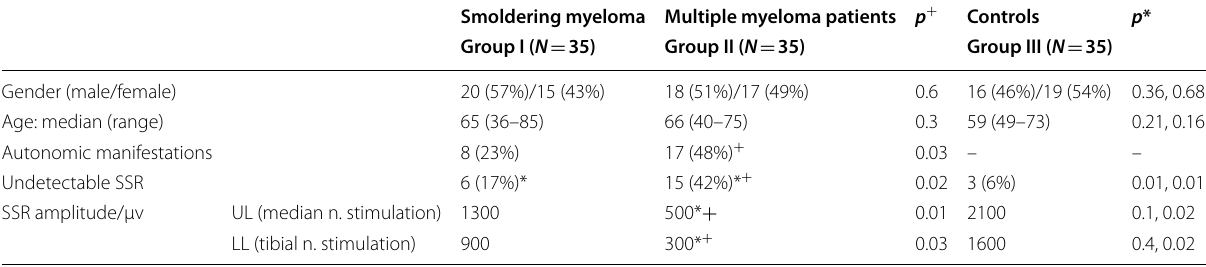
SSR sympathetic skin response, UL upper limb, LL lower limb, n nerve *Significant comparing either group I or II versus group III, + significant comparing group II versus group I Table 2 Radiological, and laboratory data of the smoldering myeloma (group I) and multiple myeloma (group II) patients Group I ( N =